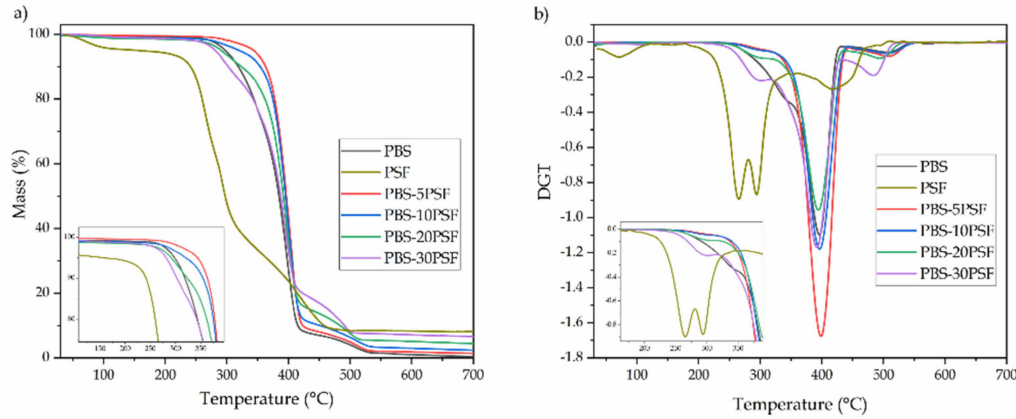
Figure 7. Thermogravimetric analysis (TGA) curves ( a ) and first derivate thermogravimetric (DTG) curves ( b ) of the injection-molded pieces of poly(butylene succinate) (PBS)/pistachio shell flour (PSF) compatibilized with poly(butylene succinate) grafted with maleic anhydride (PBS- g -MAH). Table 4. Main decomposition parameters of the injection-molded pieces of poly(butylene succinate) (PBS)/pistachio shell flour (PSF) compatibilized with poly(butylene succinate) grafted with maleic anhydride (PBS- g -MAH) in terms of onset degradation temperature at a mass loss of 5% (T 5% ), temperature of maximum degradation (T deg ), and residual mass at 700 ◦ C.